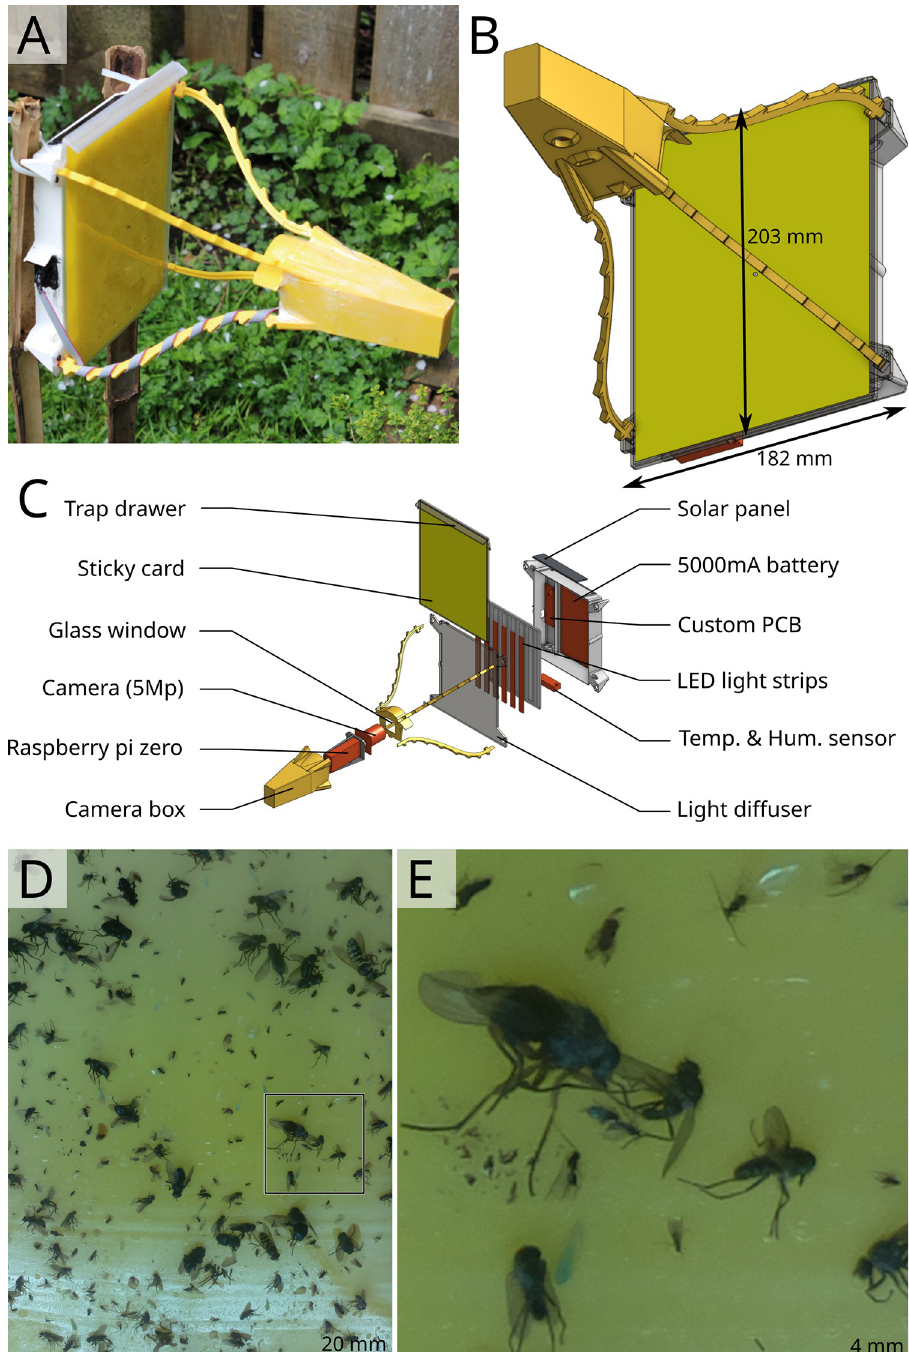
Fig 1. Sticky Pi device. (A, B) Assembled Sticky Pi. The device dimensions are 326 × 203 × 182mm ( d × w × h ). (C) Exploded view, showing the main hardware components. Devices are open source, affordable, and can be built with off-the-shelf electronics and a 3D printer. Each Sticky Pi takes an image every 20 minutes using an LED backlit flash. (D) Full-scale image as acquired by a Sticky Pi (originally 1944 × 2592 px, 126 × 126 mm). (E) Magnification of the 500 × 500 px region shown in